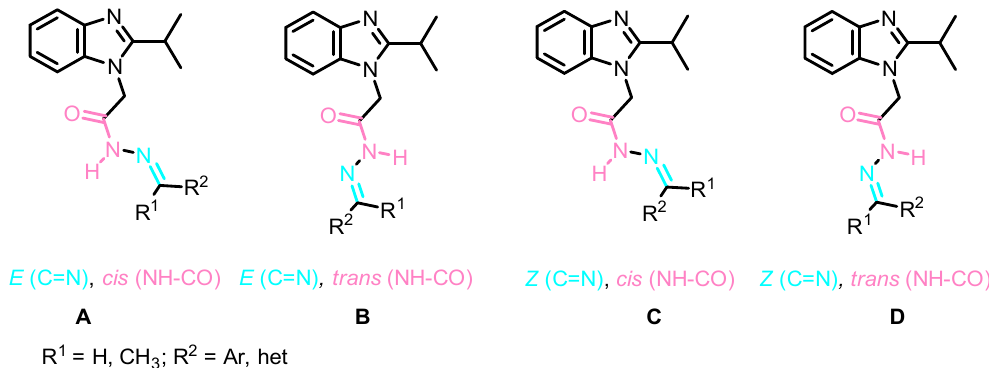
Figure 6. Molecular structure of N '-((4-hydroxyphenyl)methylidene)-2-(2-(propan-2-yl)-1 H - benzimidazol-1-yl)acetohydrazide ( 13c ) in the crystal.